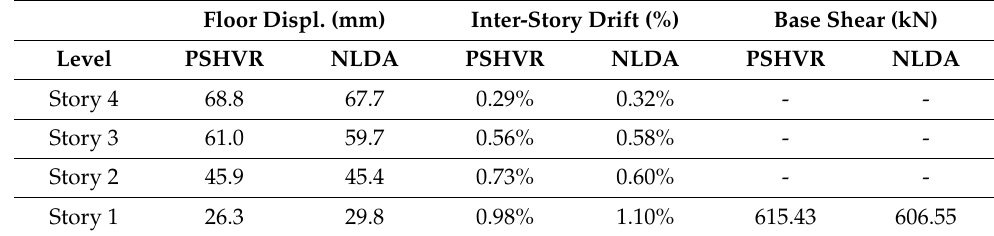
Table 5. Global story parameters: nonlinear static (PSHVR) vs. dynamic (NLDA) analyses results. Floor Displ. (mm)